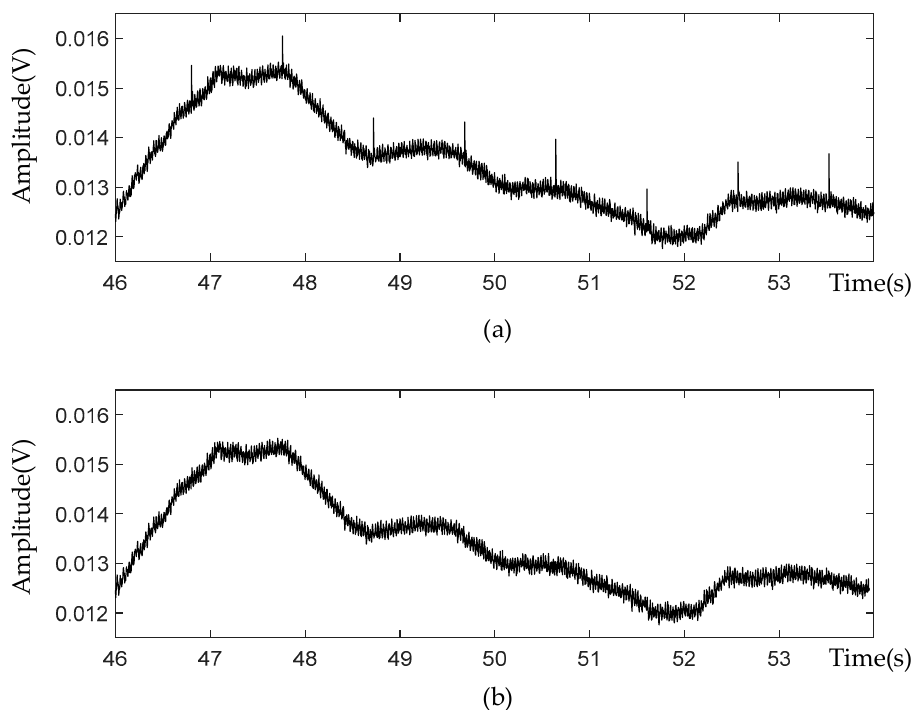
Figure 10. ( a ) EEG signals with ECG artifact, ( b ) EEG signals removing ECG interference.